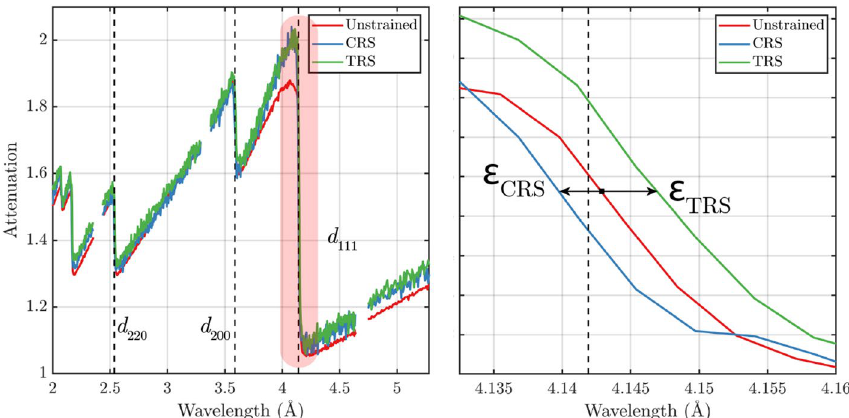
Figure 1. Spectra of the wavelength dependent linear attenuation coefficient for the unstrained annealed sample (red) and two sample zones with CRS (blue) and TRS (green), showing the Bragg edges corresponding to the lattice planes (220), (200) and (111). The right frame magnifies the wavelength region corresponding to the (111) lattice planes. The relative deviation of each of the Bragg edge wavelength positions is converted to elastic strain ǫ hkl